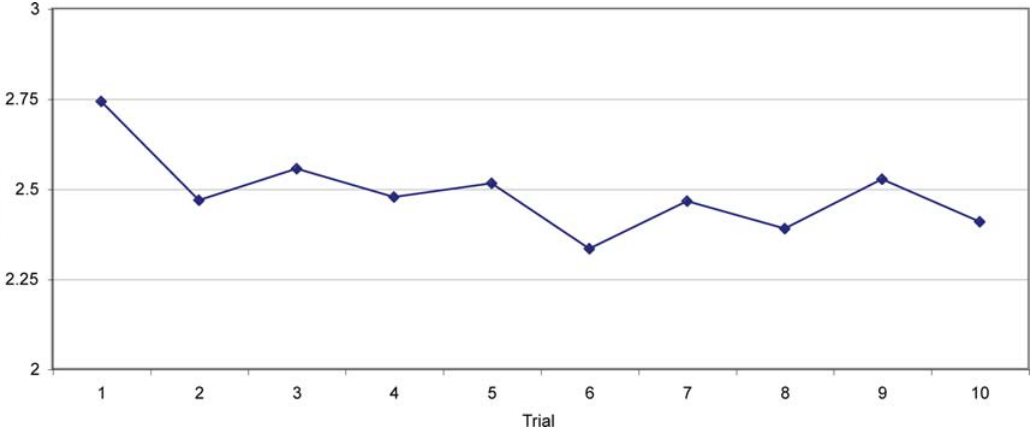
Figure 7. Cowan’s K for the first 10 trials of Experiment 4 (error bars are not displayed because Cowan’s K cannot be calculated for individual participants, who either got each item correct or